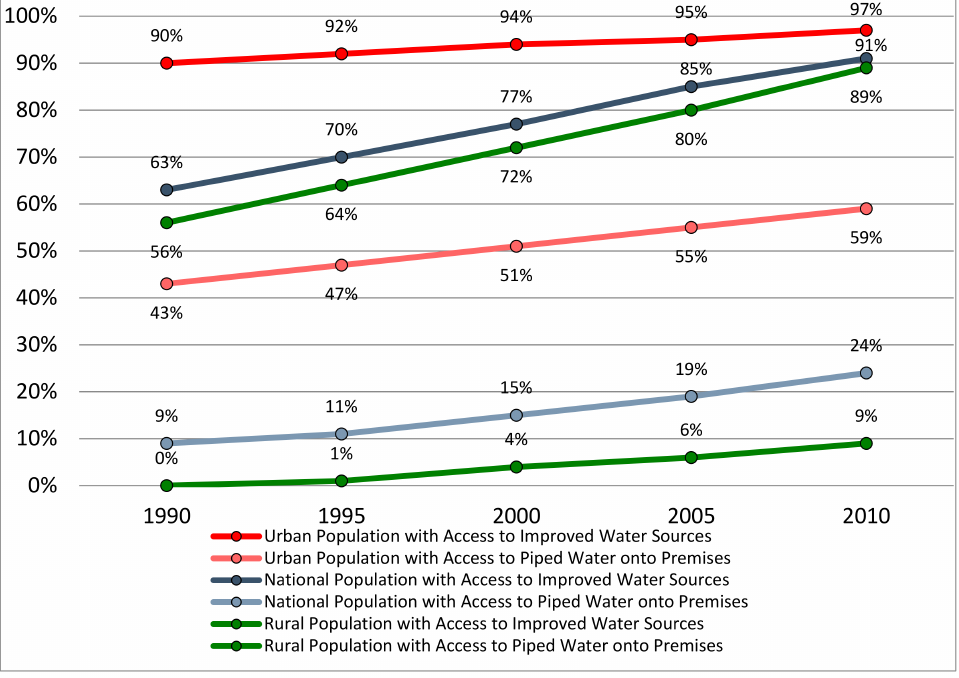
Figure 4. Detailed Vietnam’s Longitudinal Changes in Access to Improved Water Sources. Source: (UNICEF and WHO